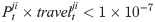
Effect of specific external policies.(A) Effects of three external policy schemes are presented. The effects are relative to the baseline model described in Fig 2. The three policy schemes are no test (rL = 0 and qL = 7), no test accompanied by prolonged quarantine period (rL = 0 and qL = 14), and test accuracy improves to 95% (θL = 0.05). (B) Effects of four external policy schemes involving travel bans and testing are presented. The effects are relative to the baseline model described in Fig 2. The strict travel ban is a 86% reduction in travel capacity quota (NiL = 0.0007%), which is equivalent to the policy in China from March 29, 2020, onward [44]. The relaxed travel ban simply doubles the travel capacity quota in the baseline, i.e. NiL = 0.01% for each i. (C) Implementation of a dynamic policy that sets a quota on the traveler capacity of NiL = 0.03% for each i, and another quota that the population share of infectious inbound travelers cannot exceed 0.00001%, i.e. the IANQ element of Ptji×traveltji<1×10−7. This is equivalent to 140 new imported cases each day for the population of mainland China. The statistics shown are the daily traveler inflow by area type determined by the dynamic policy. (D) The performances of the dynamic policy and the fixed policy are presented. The statistics shown are daily new infected cases of each policy minus the number of cases of a lockdown policy with NiL = 0, and a fixed policy with NiL = 0.03% for each i, which is equivalent to the scenario without a travel ban. For all scenarios, the number of tests is 0 (rL = 0) and the duration of quarantine for inbound travelers is 7 days (qL = 7).